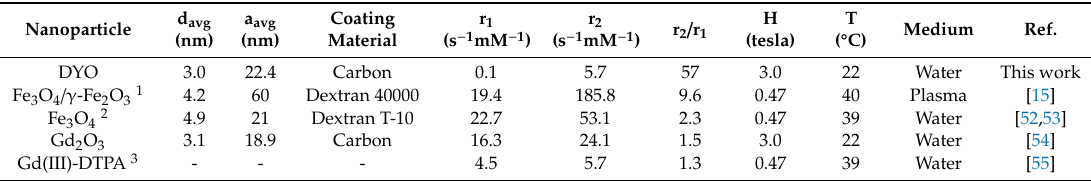
Table 3. r 1 and r 2 values of various nanoparticles and a